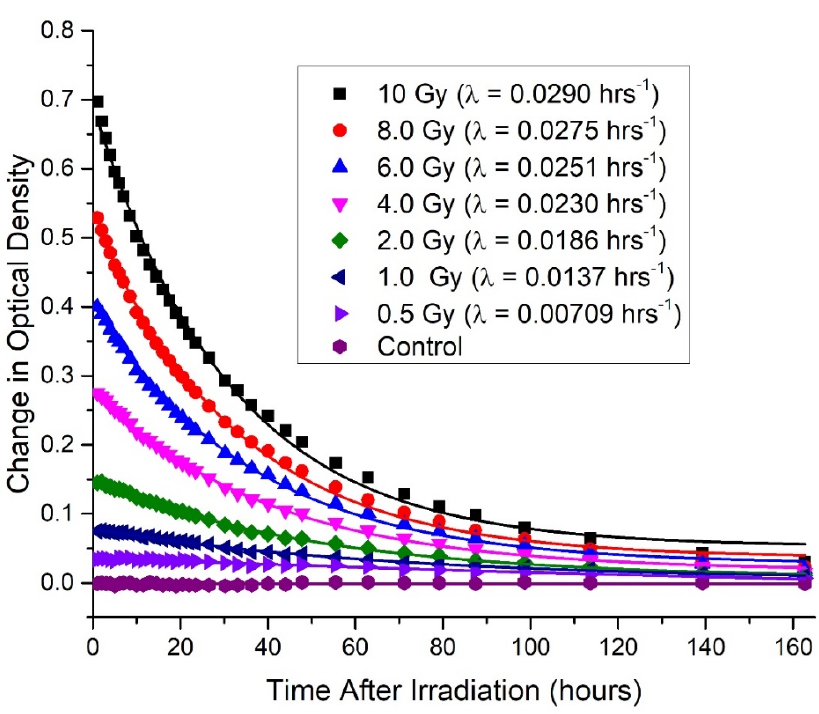
Figure 6. After initial irradiation, the clearing curves for the Formulation 3 cuvettes irradiated up to a maximum dose of 10 Gy were tracked for several days for all seven irradiated cuvettes. Fits to the curves were performed using a three-parameter fit function of the form y = y 0 + Ae −λ t .